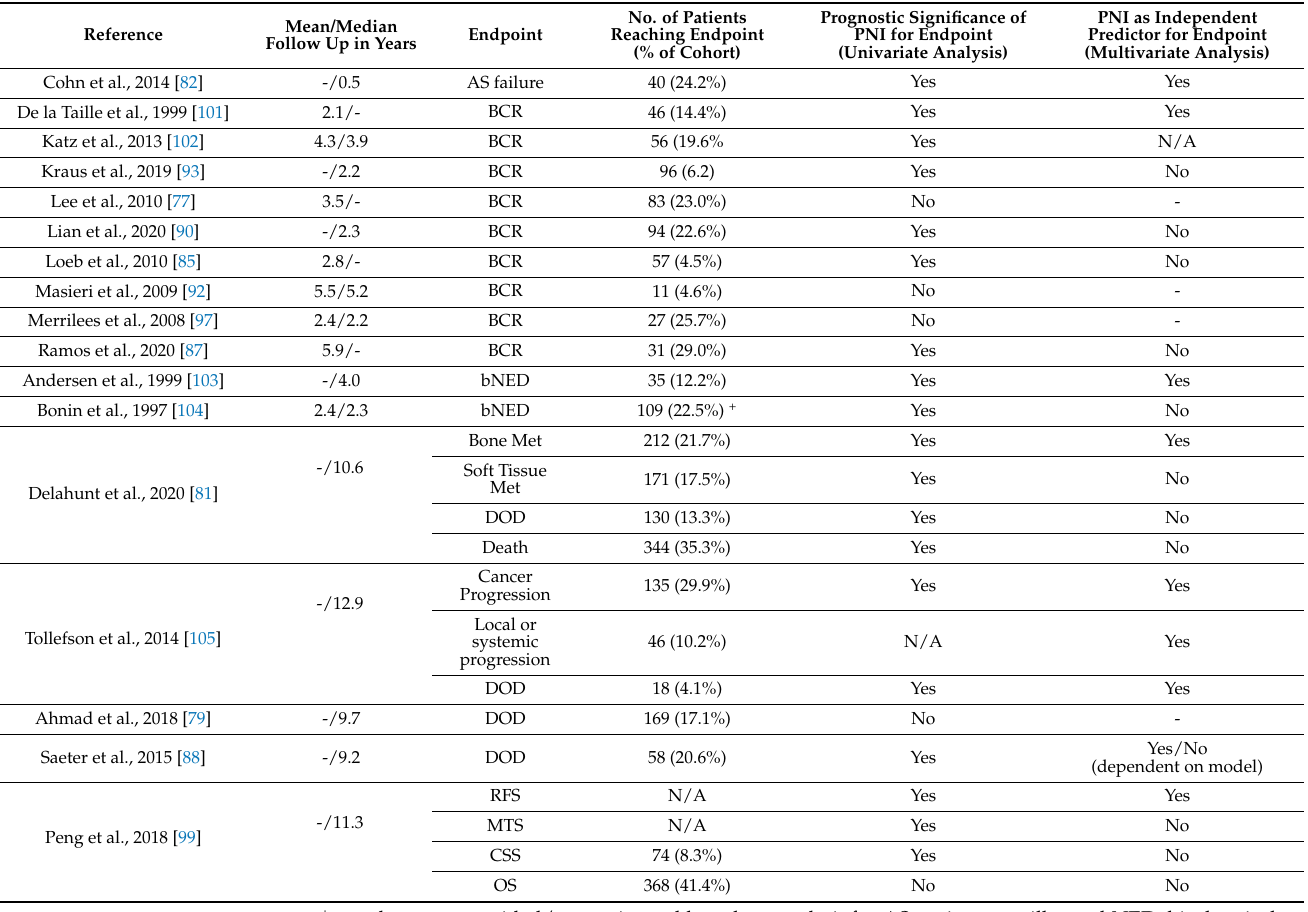
Table 2. Examples of studies investigating the clinical significance of PNI for different